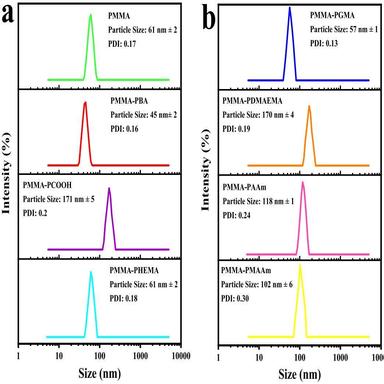
DLS curves of multi-functionalized polymer nanoparticles prepared by Emulsion copolymerization, (a) PMMA, PMMA-PBA, PMMA-PCOOH, and PMMA-PHEMA, (b) PMMA-PGMA, PMMA-PDMAEMA, PMMA-PAAm, and PMMA-PMAAm.